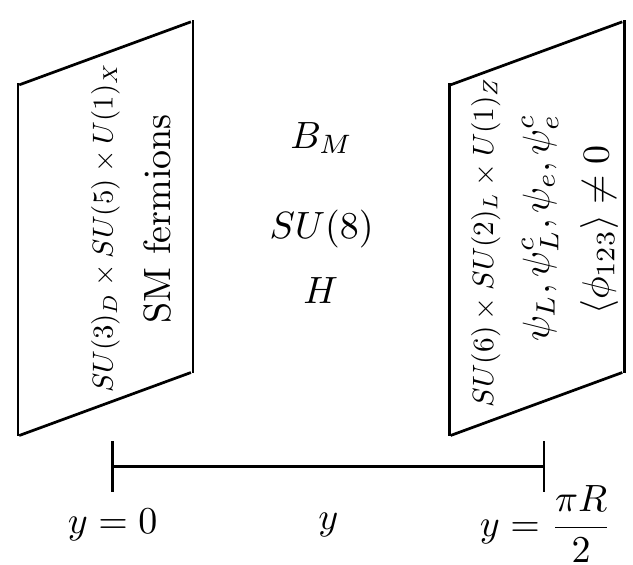
Figure 4 . Orbifold Structure for SU(8) → SU(3) D × SU(3) c × SU(2) L × U(1) Y breaking, as described in section 5.2. The bulk has an SU(8) gauge symmetry, which is broken by the boundary conditions at y = 0 and y = πR/ 2 , as indicated, with y the coordinate in the compact fifth dimension. The SM fermions live at the y = 0 boundary and do not form full representations of SU(8) , since that gauge symmetry is broken at y = 0 . The SM Higgs in embedded in an antifundamental of SU(8) in the bulk; in the low energy theory only the SU(2) L doublet remains light. The heavy vectorlike fermions ψ L , ψ e and their partners located on the y = πR/ 2 boundary generate the intermediate scale Λ that allows the dark glueballs of SU(3) D to decay to SM Higgs pairs. The heavy axion arises as the zero mode of the fifth component of a U(1) bulk vector field B M , with the mass of the axion originating primarily from SU(3) D instantons.